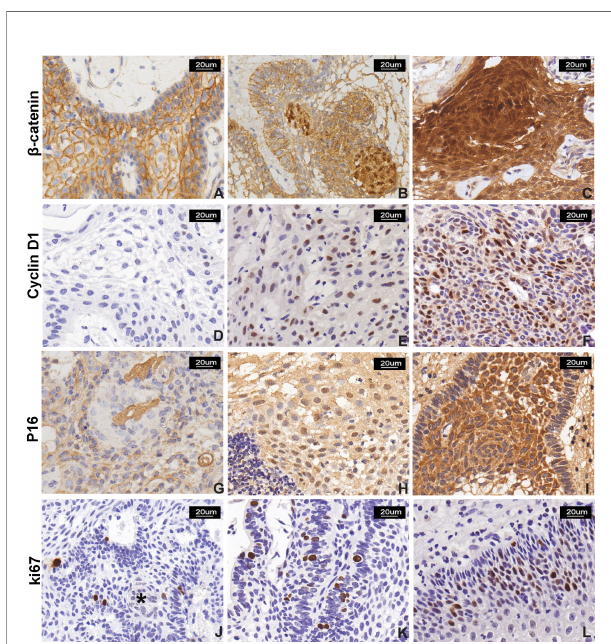
FIGURE 3 | b -Catenin, cyclin D1, P16, and Ki-67 expression in CP. (A – C) b -Catenin immunostaining score: (A) normal membranous staining in strati fi ed squamous epithelial cells in PCP, (B) moderate and strong nuclear signal in 10% – 50% and (C) >50% of neoplastic cells in two ACP cases, respectively. The signal was more represented in cells forming “ whorled epithelium ” structures. (D – F) Cyclin D1 immunostaining score: low nuclear signal observed in <10% of neoplastic cells ( D , a case of PCP); moderate signal observed in 10% – 50% of cells ( E , a case of PCP); and strong reactivity in >50% of neoplastic cells ( F , a case of ACP). (G – I) P16 immunostaining score: (G) signal with low intensity observed in <10% of neoplastic cells